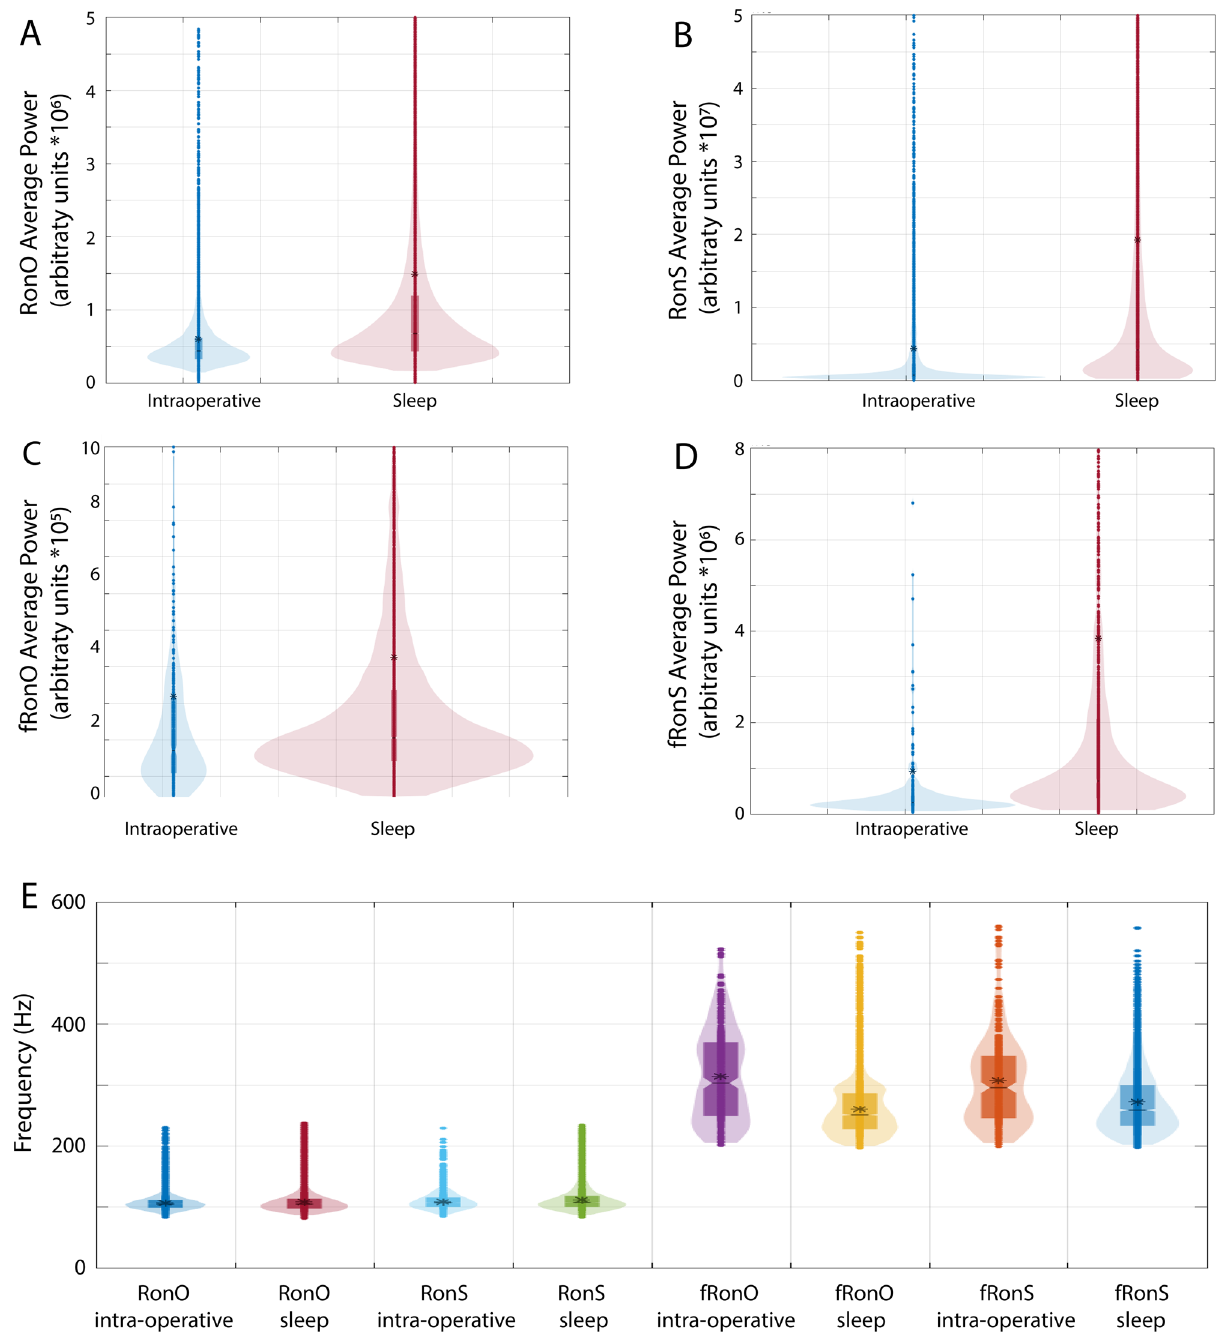
Figure 1. Differences in HFO average power and frequency by recording condition (intraoperative vs. non-REM sleep). Violin plots of ripples on oscillations (RonO, A ), ripples on spikes (RonS, B ), fast ripples on oscillations (fRonO, C ), and fast ripples on spikes (fRonS, D ) average power. HFO power was greater for all the event types, except fRonO, during non-REM sleep (red) than intraoperative recording (blue, p < 0.01). ( E ) Violin plots of HFO spectral frequency. There was a small, but significant, increase in RonO and RonS frequency ( p < 0.01) and decrease in fRonO and fRonS frequency ( p < 0.01) during non-REM sleep than during intraoperative recording. Asterisk indicates